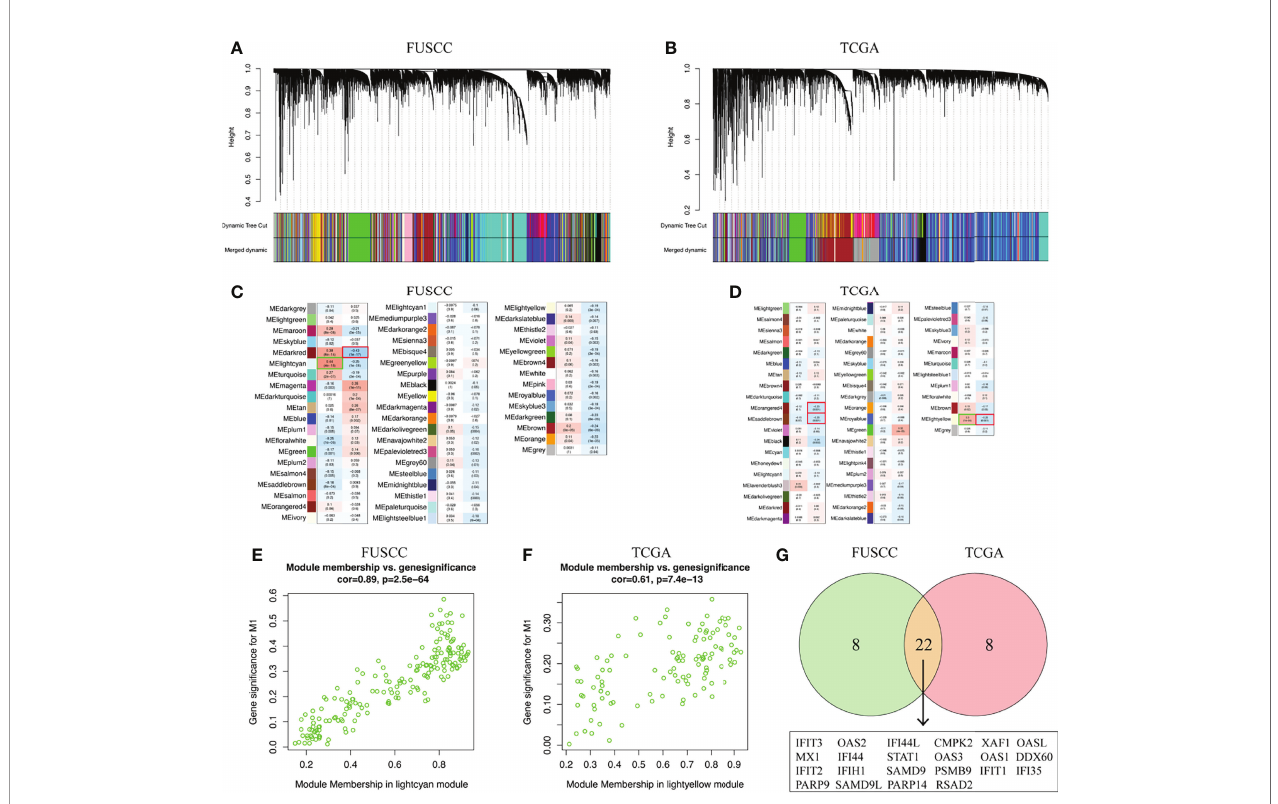
FIGURE 5 | Key marker genes associated with M1 macrophages in fi ltration was explored. (A, B) WGCNA was used to construct a scale-free network with a power of 5 in FUSCC and TCGA cohorts. (C, D) The correlation between 54 and 52 gene modules, respectively, and M1 macrophage in fi ltration were calculated. (E, F) Module membership in lightcyan and lighteyellow from FUSCC and TCGA were con fi rmed to be highly correlated with M1 macrophage in fi ltration. (G) Genes that overlap in lightcyan module from FUSCC and lightyellow module from